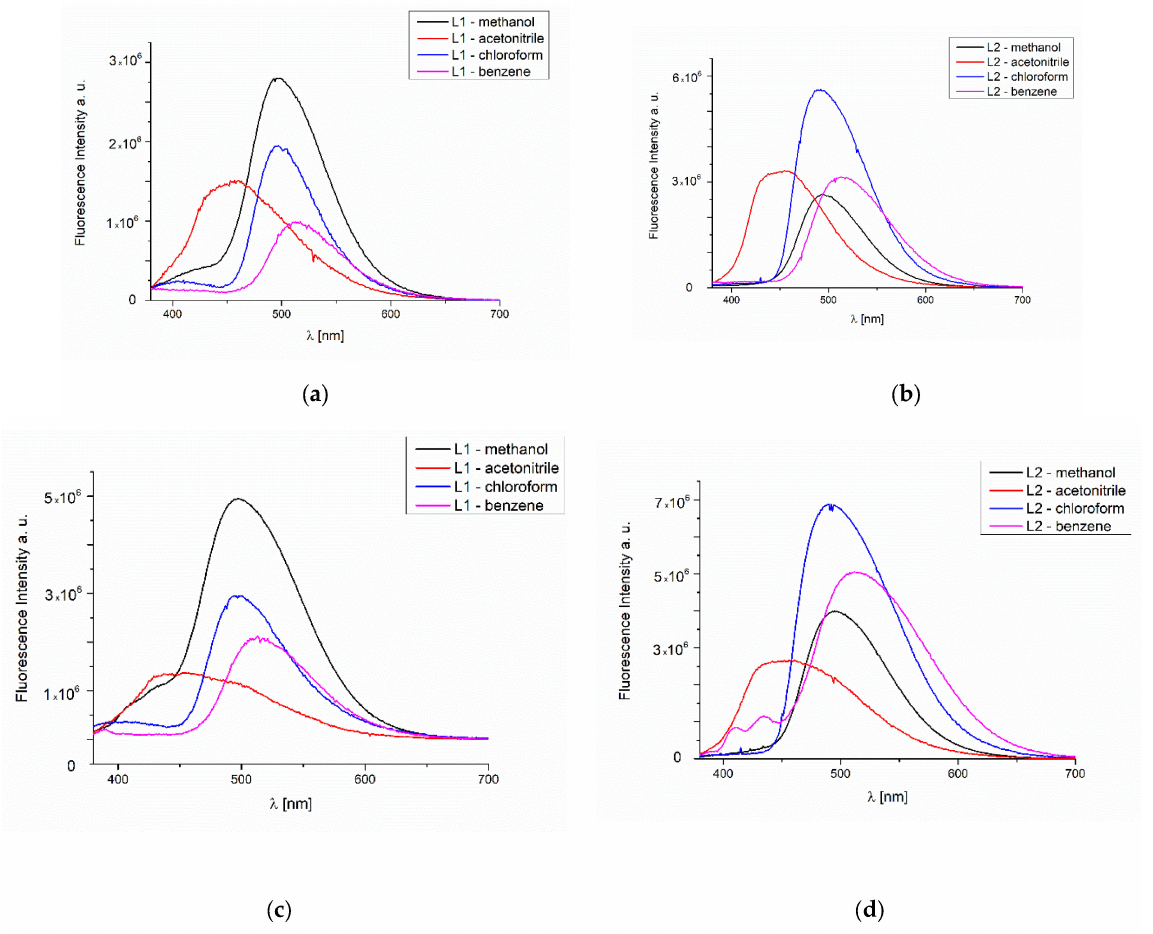
Figure 8. Solution emission spectra of L1 and L2 . ( a ) L1 ( b ) L2 λ ex = 295 nm, ( c ) L1 ( d ) L2 λ ex = 350 nm, (chloroform, acetonitrile, benzene (1.7 × 10 − 5 mol/dm 3 , RT) and methanol (2 × 10 − 5 mol/dm 3 , RT) for L1 , (1,4 × 10 − 5 mol/dm 3 , RT) for L2